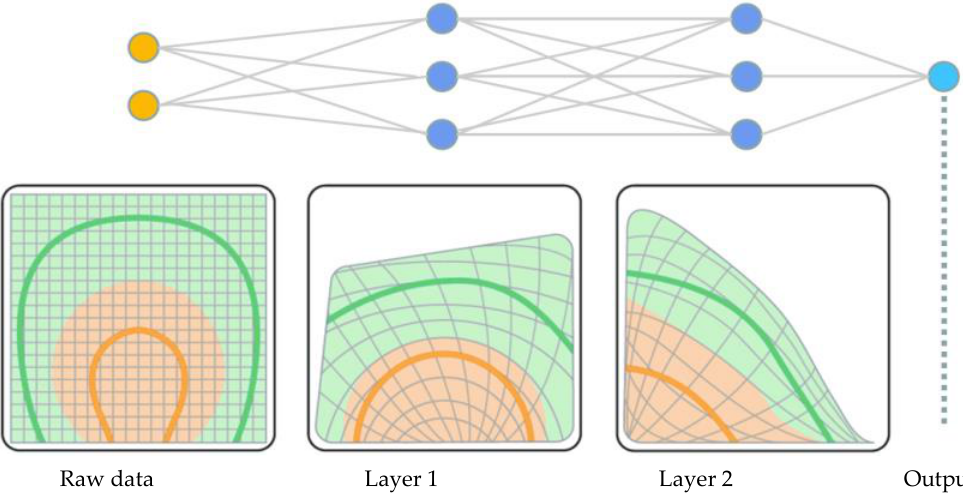
Figure 1. When data flows from one layer to another of the neural network, they are linearly separated by iteratively distorting the data. The final output layer outputs the probabilities of any class. This example illustrates the basic concepts of large-scale network usage.